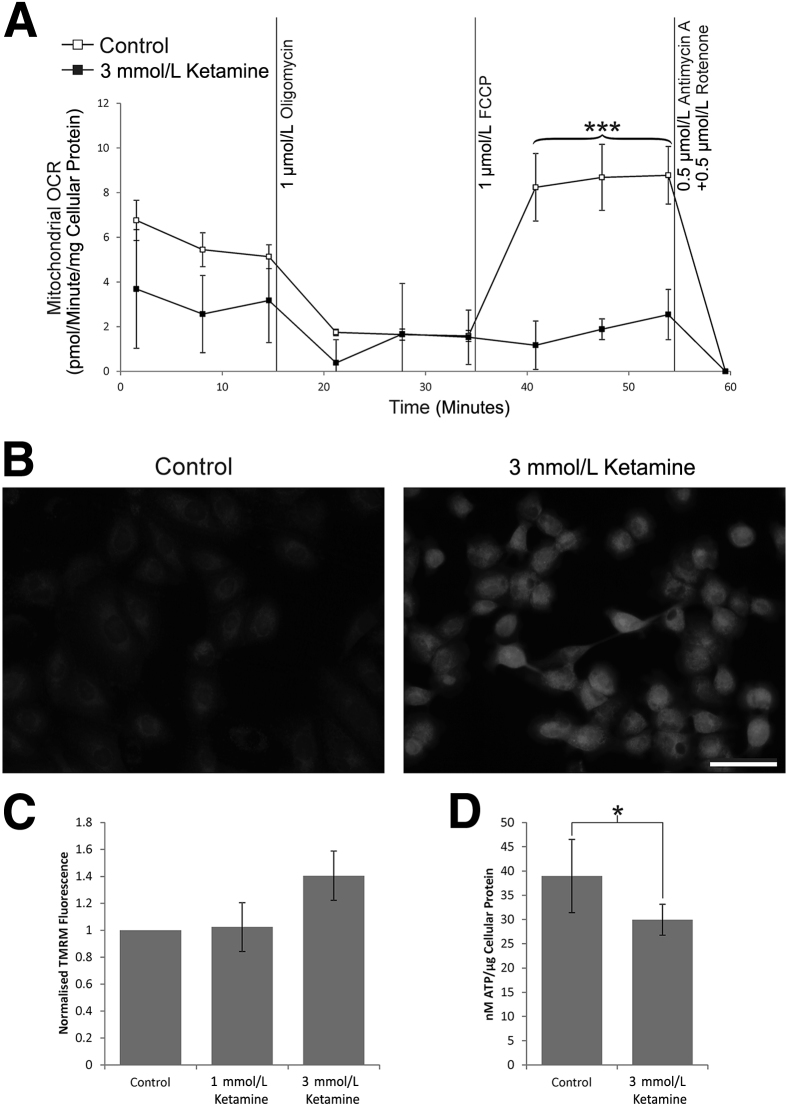
Ketamine exposure causes mitochondrial stress in normal (nonimmortalized) human urothelial (NHU) cells. A: NHU cells exposed to 3 mmol/L ketamine for 48 hours had a significantly lower resting mitochondrial oxygen consumption rate (OCR) than controls (54.4%; Mann-Whitney test P < 0.001). The proportion of OCR devoted to physiology other than ATP generation remained the same, whereas the spare mitochondrial capacity in control cells was far greater (4.6-fold; Mann-Whitney test). Data are the means of experiments performed in duplicate on three independent cell lines. B: NHU cells labeled with tetramethylrhodamine (TMRM) showed that 3 mmol/L ketamine exposure led to elevated mitochondrial membrane potential (images are representative of experiments performed in cells from three donors). C: Results in B were confirmed quantitatively by flow cytometry (mean of three independent donor cell lines given). D: Cellular ATP was significantly reduced to 76.8% of control after 3 mmol/L ketamine exposure for 48 hours. Data are the means of duplicate measurements in three independent donor cell lines. Error bars represent SD (A, C, and D). ∗P < 0.05, ∗∗∗P < 0.001. Scale bar = 50 μm (B). FCCP, carbonyl cyanide-4-(trifluoromethoxy)phenylhydrazone.